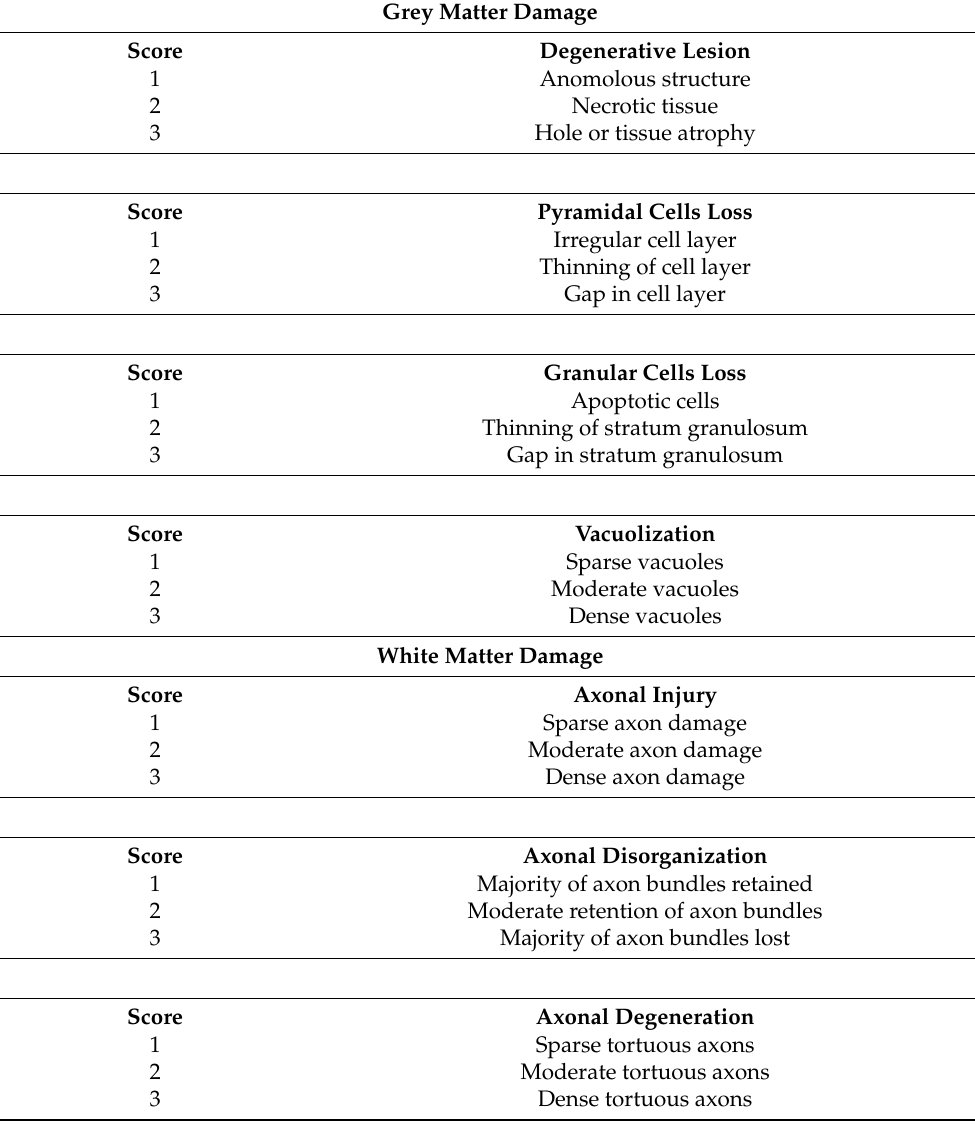
Table 1. Tissue Scoring and